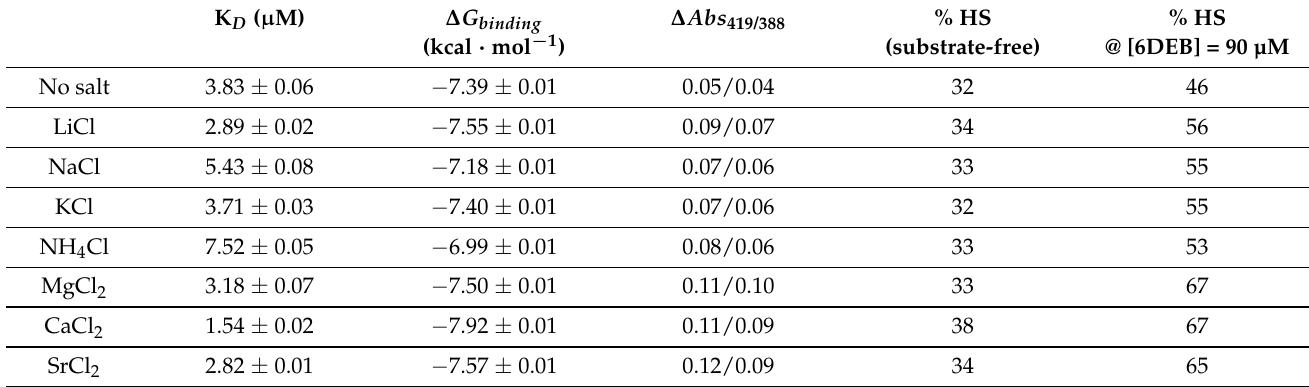
Table 1. Affinity constant and high-spin content for the binding of 6DEB to OleP in different salt conditions (I = 0.5 M).